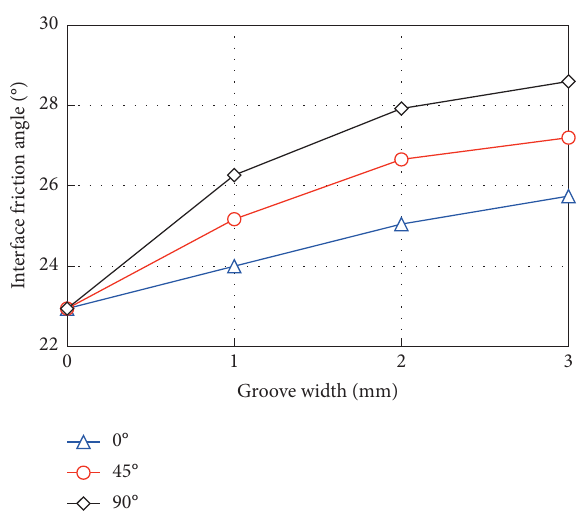
Figure 14: Relationship between interface friction angle and groove width for steel-sand